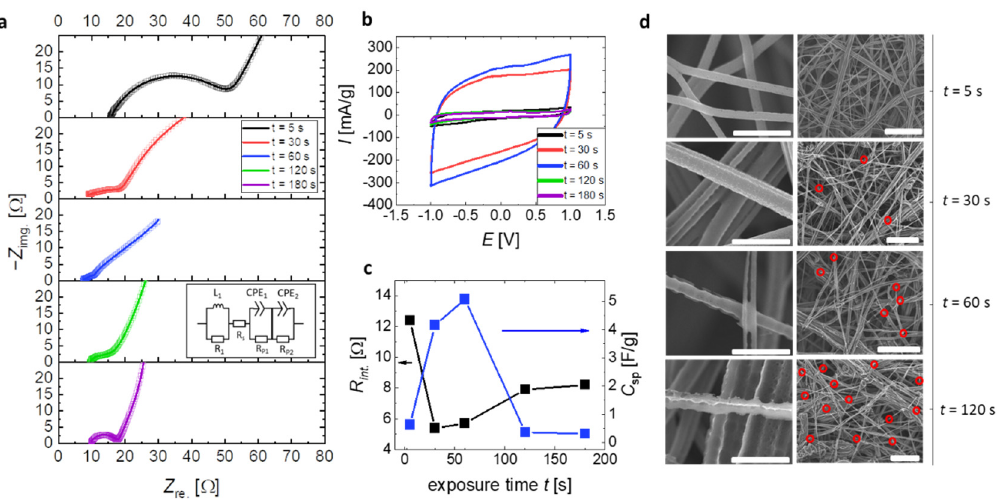
Figure 4. ( a ) Nyquist-plots with raw data points as hollow squares, fit as solid line and the used equivalent circuit in the inset, ( b ) cyclic voltammograms at 50 mV/s with the mass weighted current I and the electric potential vs. Ag-wire E and ( c ) specific capacitance C sp and internal resistance R int. of carbon nanofiber nonwoven, carbonized for various durations. ( d ) Close-up and wide-angle SEM-images of carbon-nanofiber nonwoven, carbonized for various plasma-jet exposure times. Red circles highlight breakage points of individual fibers. The scalebars indicate 2 µm (left row in d ) and 20 µm (right row in d ). Electrochemical measurements in ( a – c ) were conducted with the ionic liquid 1-Ethyl-3-methylimidazolium bis(trifluoromethylsulfonyl)imide, which was found to fully wet the nonwovens with a contact angle of 0°.